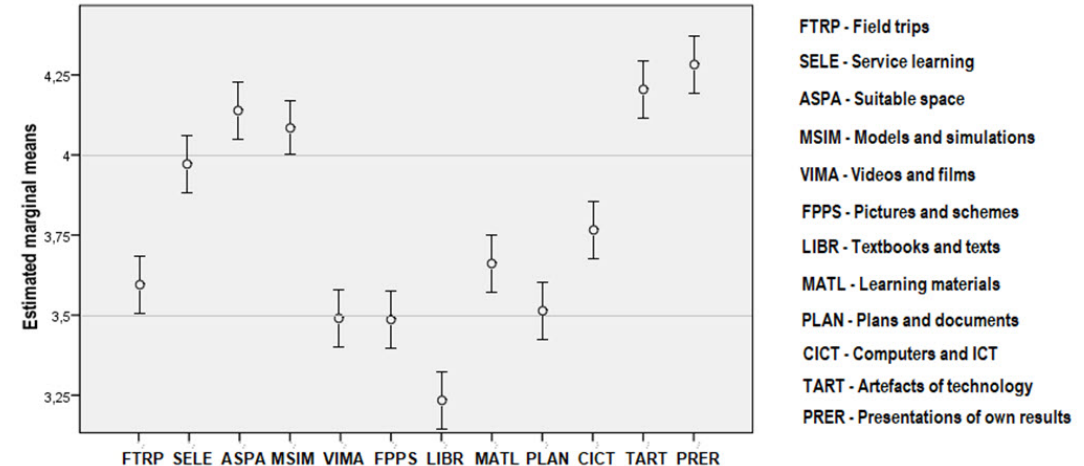
Figure 5. Estimates of the influence of contextual elements on pupils’ self-regulated